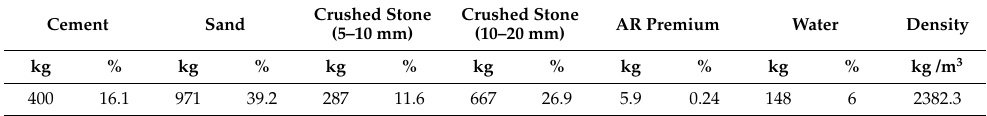
Table 12. Reference composition of RHC grade C 25/30.